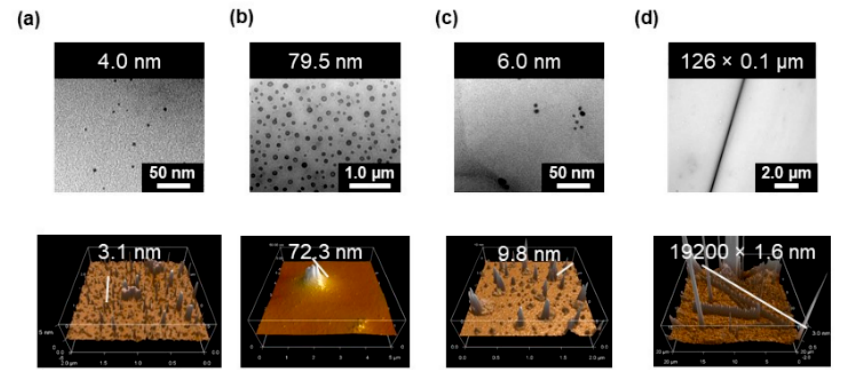
Figure 8. Transmission electron microscopy (TEM) images (upper) and AFM image (lower) for each sample. Measurement was conducted after dropping the solution on the surface of the carbon-coated Cu grids. ( a ) [3] 3 + = 6.0 mM, [2] + = 12.0 mM. ( b ) [( 3 ) · α -CD] 3 + = 3.4 mM, [3] 3 + = 2.6 mM, [2] + = 12.0 mM, [ α -CD] = 8.6 mM. ( c ) [( 3 ) · β -CD] 3 + = 6.0 mM, [2] + = 12.0 mM. ( d ) [( 3 ) 2 · γ -CD] 6 + = 3.0 mM, [2] = 12.0 mM.